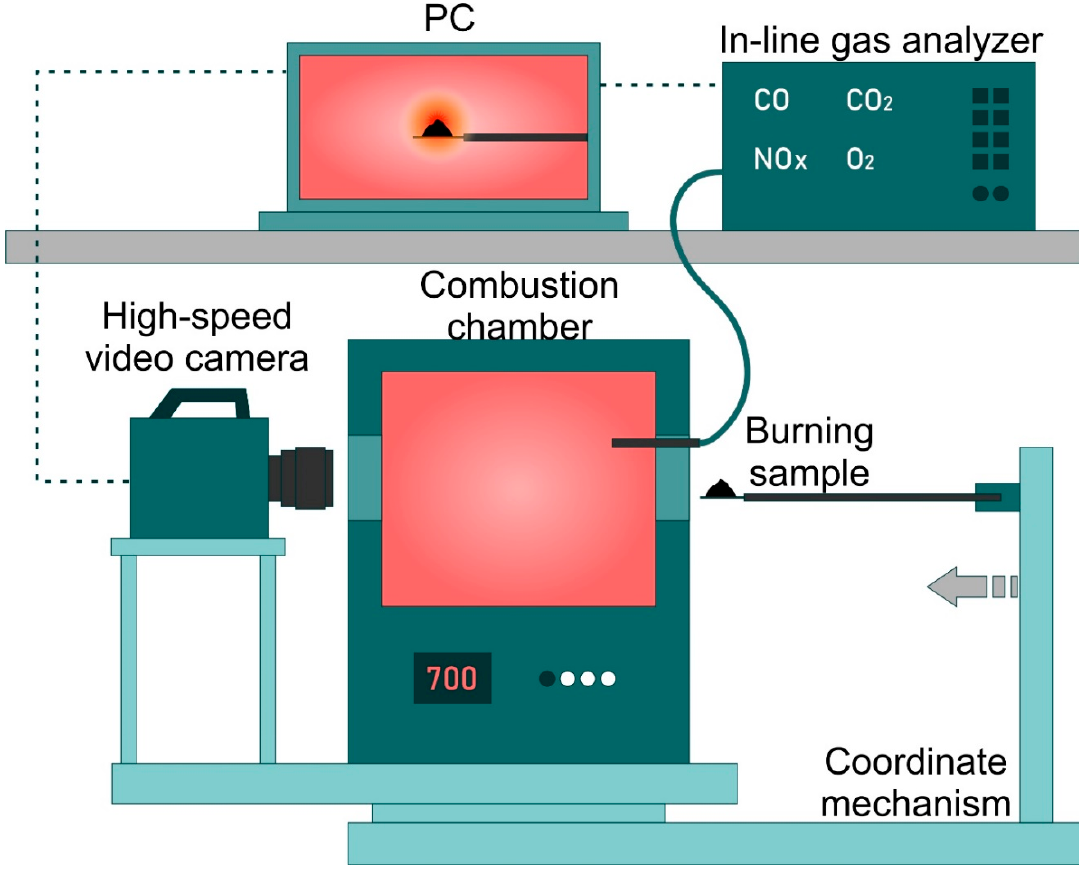
Figure 2. Experimental setup for studying the combustion process of the solid fuels.